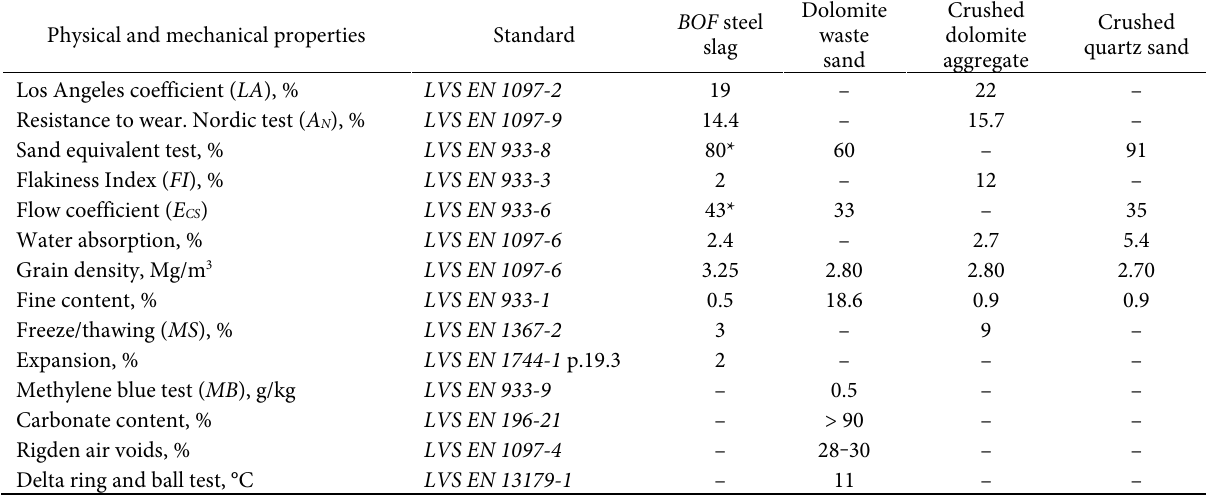
Table 3. Conventional and co-product aggregate gradation